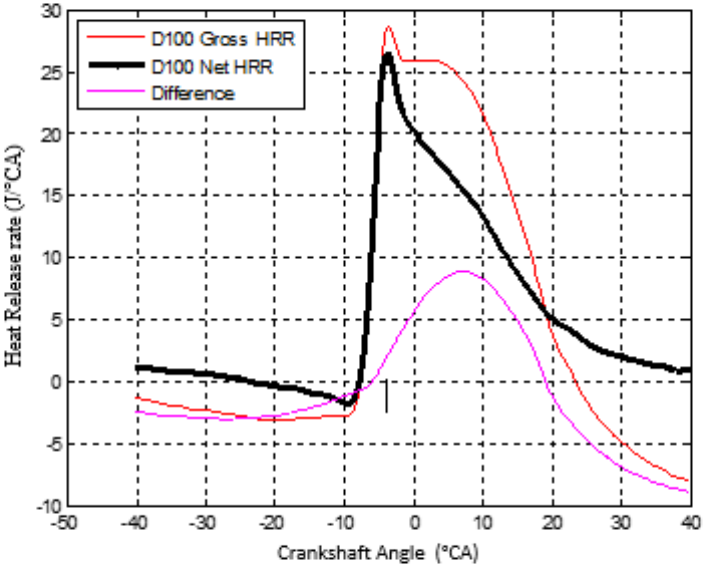
Figure 12. Profile of net heat release rate (Net HRR) evolution and gross heat release rate (Gross HRR) for engine speed n = 1500 rpm at 75% load according to D100 combustion.